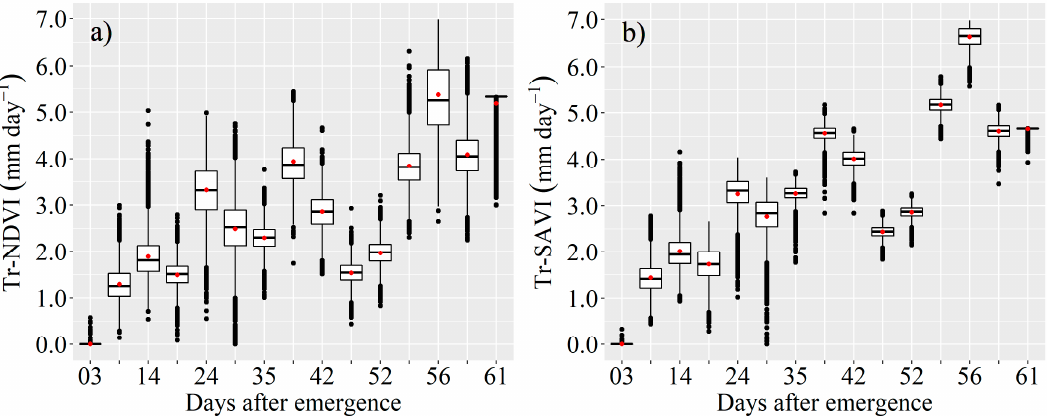
Figure 6. Descriptive statistics of the actual transpiration of maize crop by the models derived from the NDVI ( a ) and SAVI ( b ).